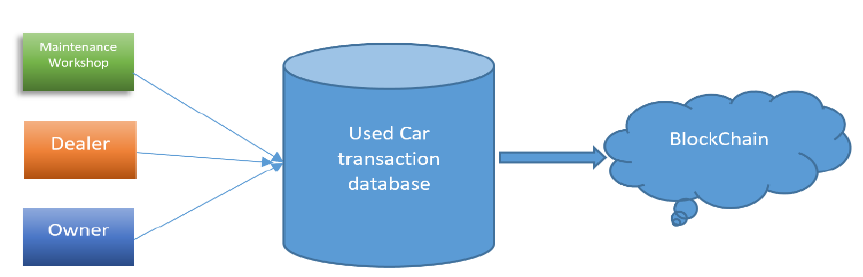
Figure 6. The Blockchain system in